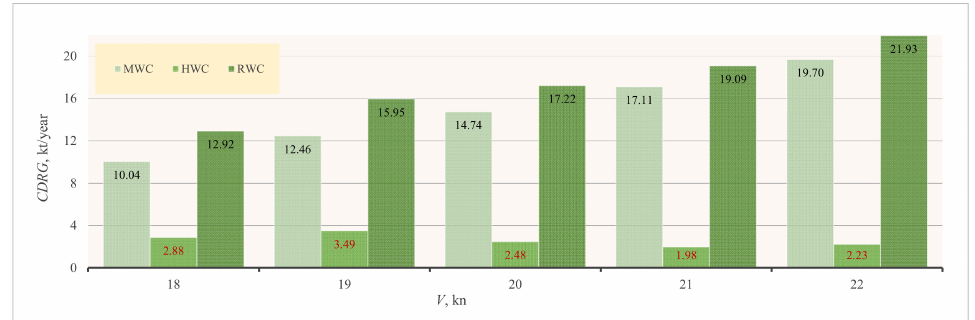
Figure 32. The CO 2 reduction per year for ship gasification under MWC, HWC, and